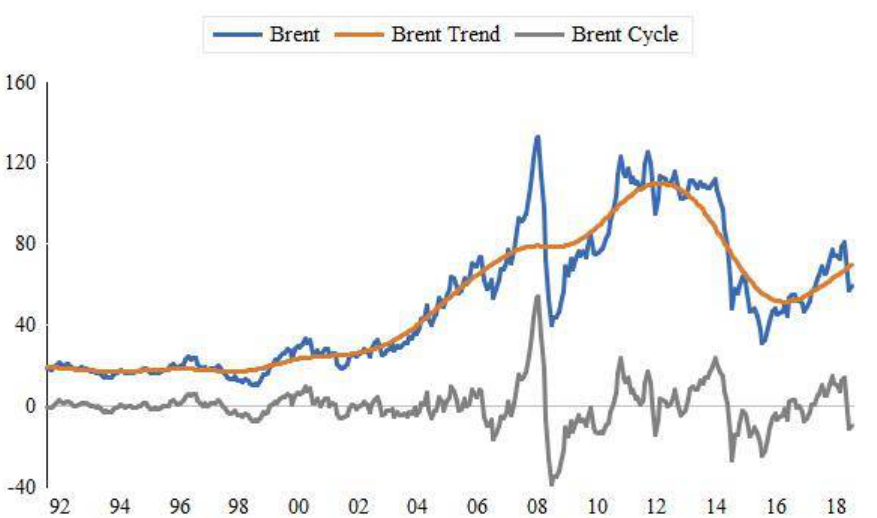
Figure 2. Trend and cyclical components of the Brent spot oil price. (FOB, dollars per barrel). We obtain a one-period ahead forecast of monthly volatility from the GARCH-M model (3). The volatility Vol T of the year T is measured as the monthly average of the one- year window: